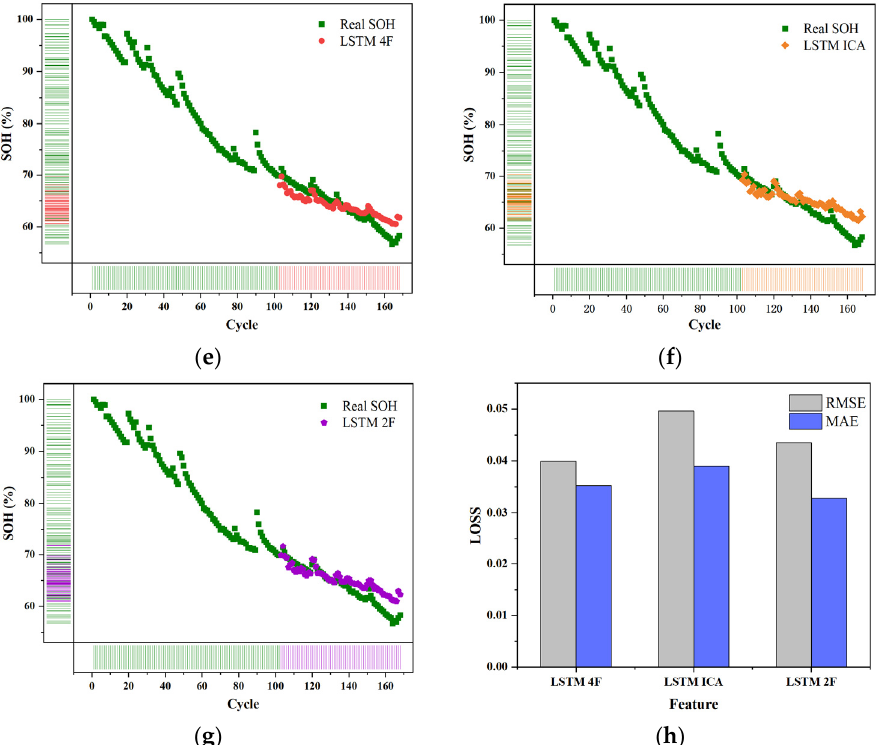
Figure 5. LSTM for 5# and 6# batteries ( a – c ). The predicted results of different features for 5#. ( d ) The loss of battery 5# ( e – g ). The predicted results of different features for 6# ( h ). The loss of battery 6#.